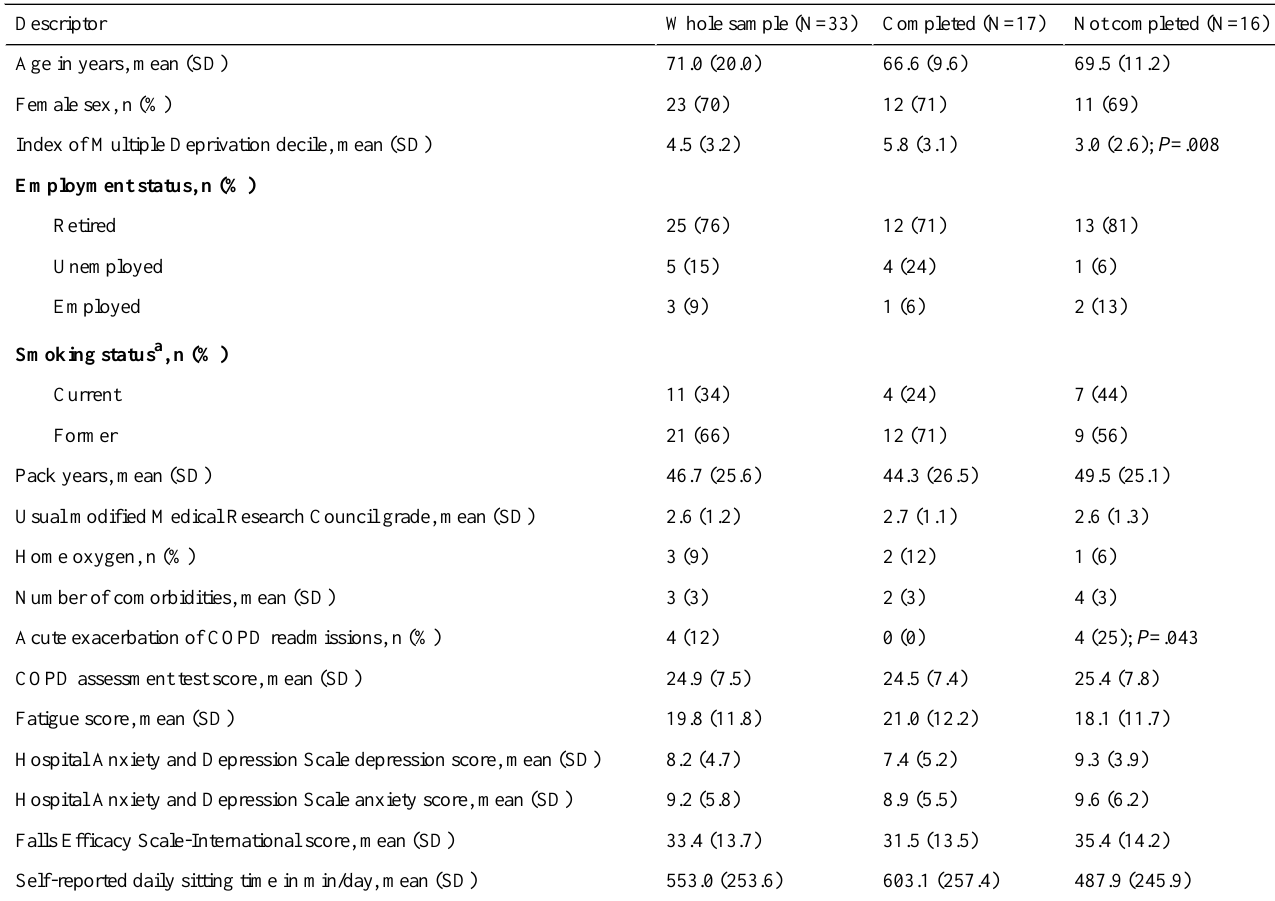
Table 1. Patient characteristics for the whole sample and stratified by attendance at the 2-week follow-up appointment. COPD: chronic obstructive pulmonary